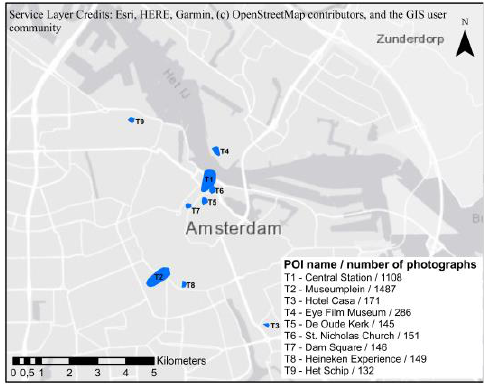
Figure 3. Distribution and number of photographs per POIs